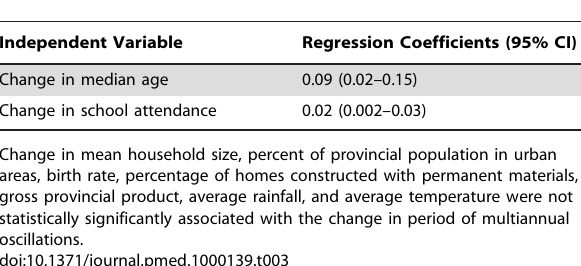
Table 3. Results of univariate linear regression of change in the period of multiannual oscillations from 1985 to 2005 on demographic, socioeconomic, and climatic characteristics of provinces.